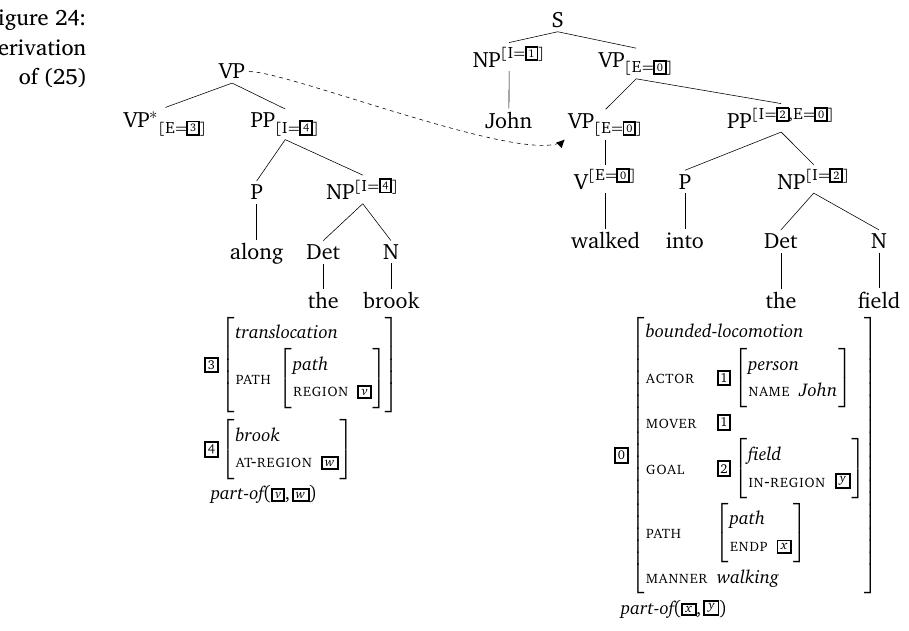
Figure 24: Derivation of